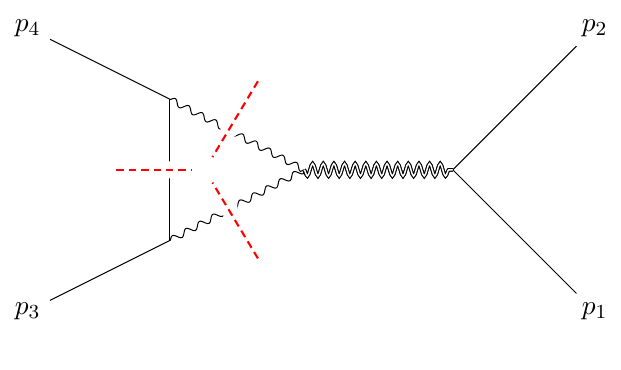
Figure 3 . LS Triangle